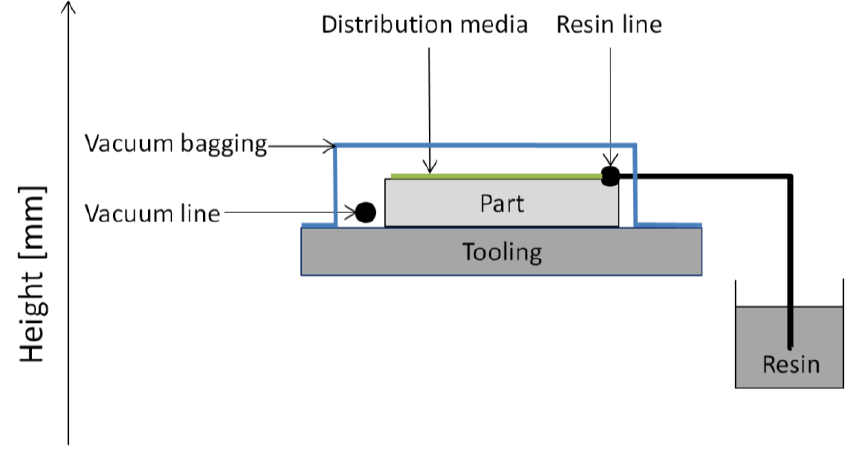
Figure 2. Vacuum-assisted resin infusion (VARI) procedure according to [4,5].